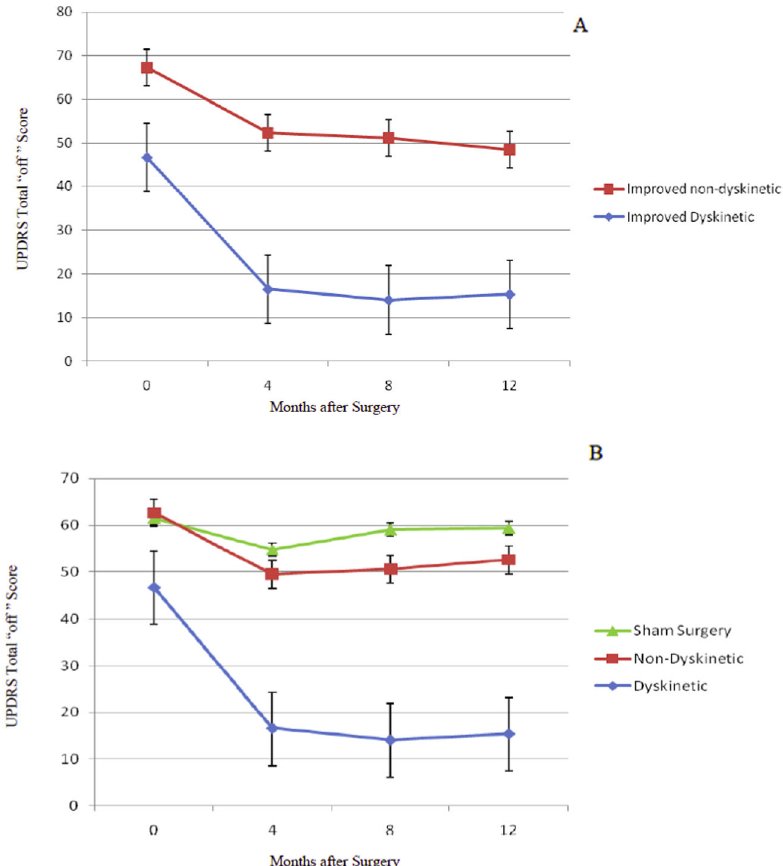
Fig. 2 Change in total UPDRS “ off ” scores for younger transplant and sham surgery patients during the double-blind phase. This fi gure presents a subset of patients shown in Fig. 1. All data in this fi gure were obtained in the double-blind phase. Analysis of UPDRS Total “ off ” scores 12 months after surgery demonstrated that the 10 younger transplanted subjects distributed into two groups, those who improved, n = 7, and those who did not, n = 3. As in Fig. 1A, data are divided based on improvement, de fi ned as greater than 10% reduction in UPDRS Total “ off ” scores compared to baseline. Panel A presents results from subjects who improved after surgery. Of the seven who improved, three showed persistent dyskinesias (Improved Dyskinetic, n = 3), and 4 were improved without dyskinesias (Improved non-dyskinetic, n = 4). As with the full group presented in Fig. 1A, the dyskinetic patients had milder Parkinson signs at baseline and improved to a level of minimal disease. The improved, non-dyskinetic subjects had more severe signs preoperatively and remained with moderate Parkinson scores after 12 months. Transplanted subjects who did not improve in the fi rst 12 months after surgery ( n = 3) had outcomes similar to the sham surgery subjects ( n = 11) (data not shown). There were no placebo effects. Panel B presents results comparing the three dyskinetic subjects to all other transplanted patients, whether improved or not improved, and to sham surgery subjects. When presented using this format and analyzed by one-way ANOVA, the dyskinetic subjects were signi fi cantly improved compared to the combined Improved and Not Improved non-dyskinetic transplant patients and to the sham surgery subjects ( p < 0.01) (Dyskinetic, n = 3; Non-Dyskinetic, n = 7; Sham Surgery, n = 11). There was no statistical difference between the Non-Dyskinetic and Sham Surgery groups in this small subset of